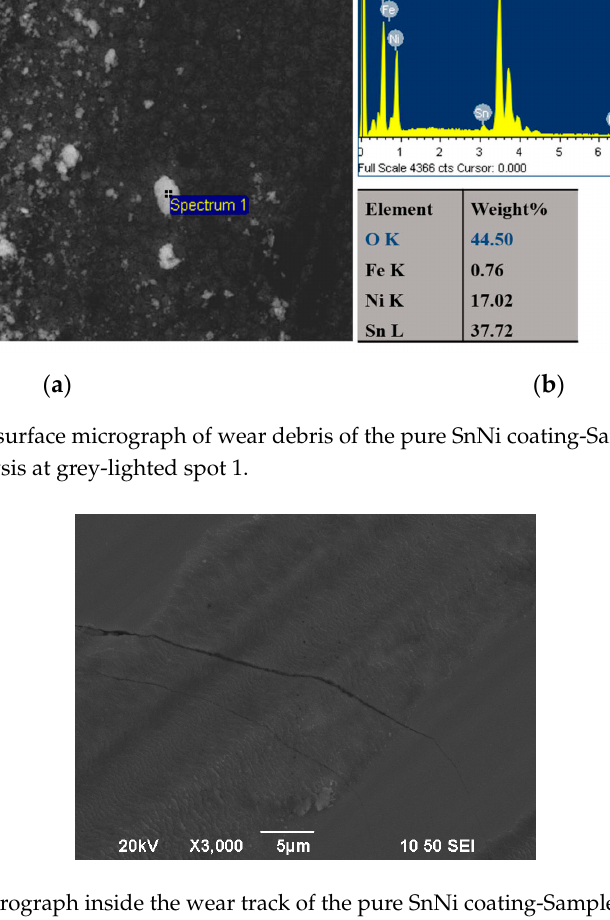
Figure 16. SEM micrograph inside the wear track of the pure SnNi coating-Sample I (magnification of area shown in Figure 13b.